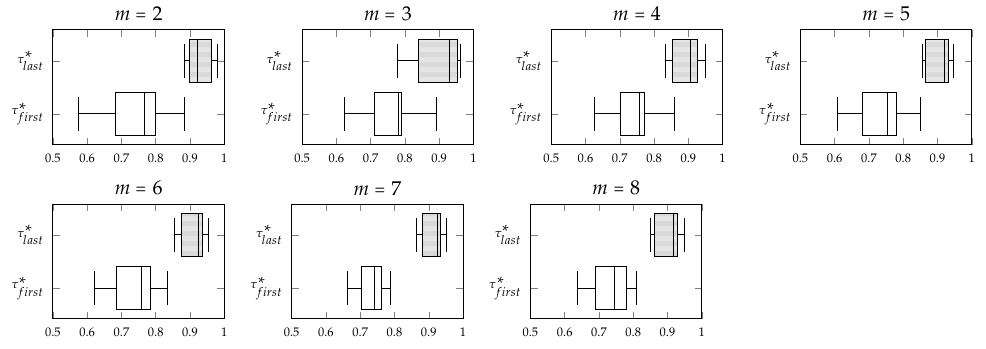
and τ ∗ computed by SK2 according to number first last